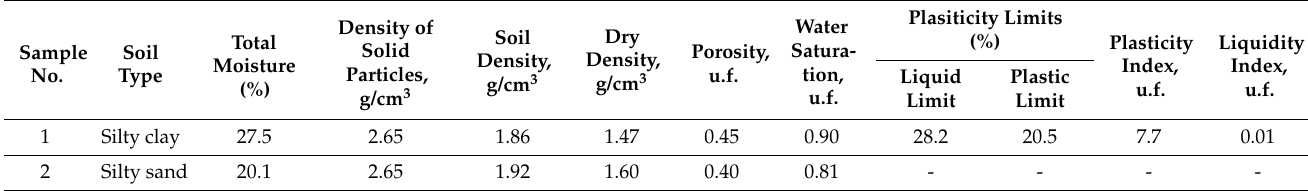
Table 1. Main soils parameters.